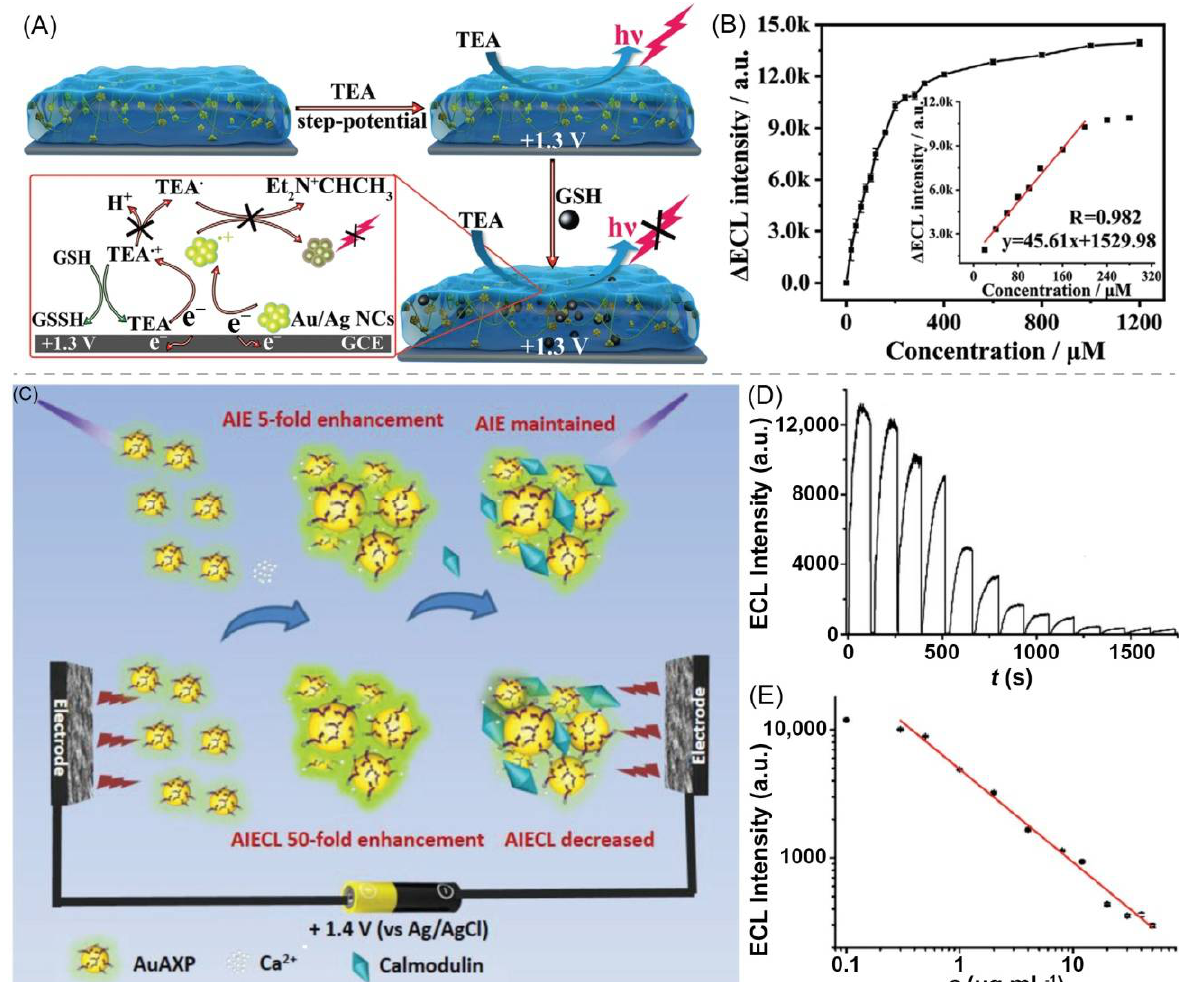
Figure 5. ( A ) Schematic of mechanism of GSH sensing by Au/Ag NCs@BSA hydrogel. ( B ) Calibration plot about ΔECL intensity as a function of GSH concentration with inset being linear relationship between ΔECL intensity and GSH concentration. Adapted with permission [97]; copyright 2020, Wiley–VCH Verlag GmbH & Co. KGaA, Weinheim. ( C ) Schematic of ECL calmodulin sensor based on bivalent cations-NCs hydrogel. ( D ) Relationship between ECL intensity and CaM concentration. (0–50 μg mL −1 from left to right) ( E ) ECL intensity as a function of CaM concentration. Adapted with permission [98]; copyright 2019, Wiley–VCH Verlag GmbH & Co. KGaA, Weinheim.